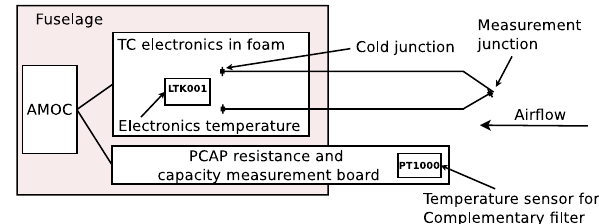
Fig. 3. Schematic drawing of the complete thermocouple measure- ment strategy.